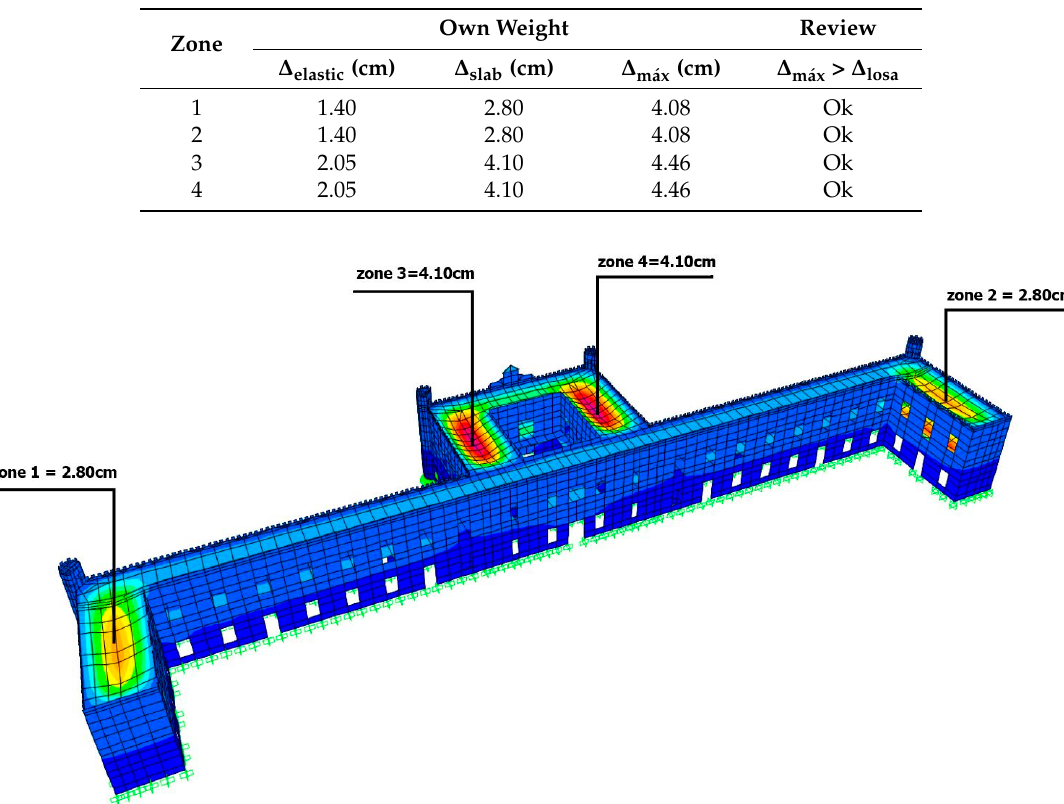
Table 6. Characteristics of the first 4 vibration modes. Mode 1; T = 0.590 s